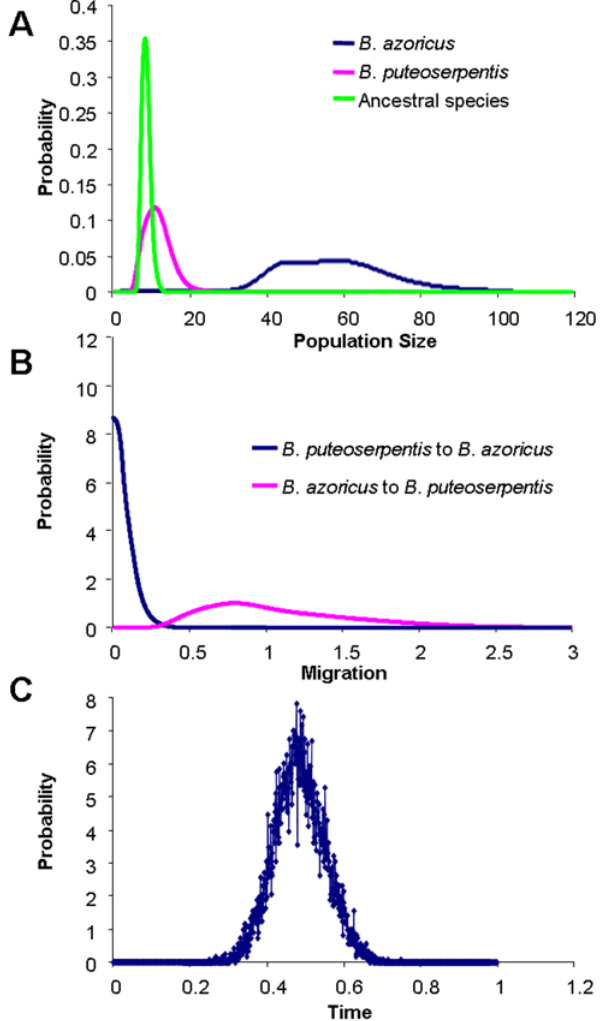
Figure 7. The marginal posterior probability distribution for model parameters (scaled by the neutral mutation rate). Curves are shown for the analysis with and for all B. azoricus and B. puteoserpentis (a) population size, (b) migration, (c) divergence time.